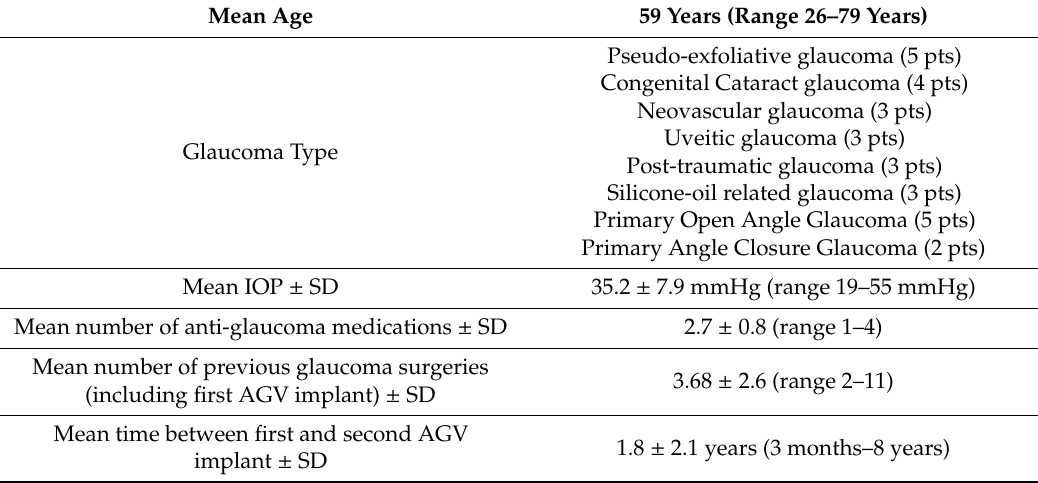
Table 1. Demographic and clinical characteristics of the patient